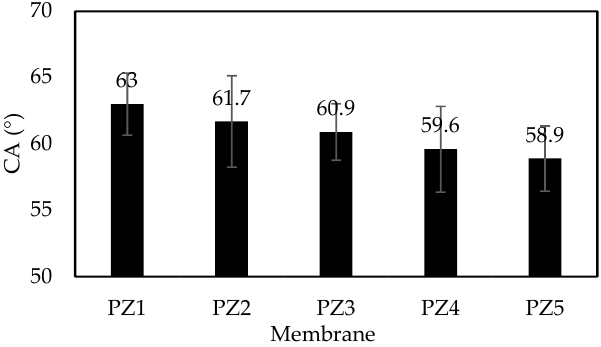
Figure 1. The contact angle of membrane PZ1 to PZ5.